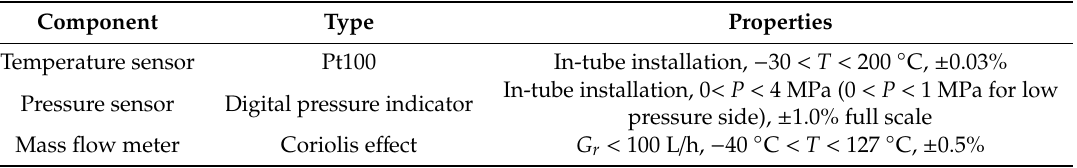
Table 2. Measurement sensors installed in the experimental setup.